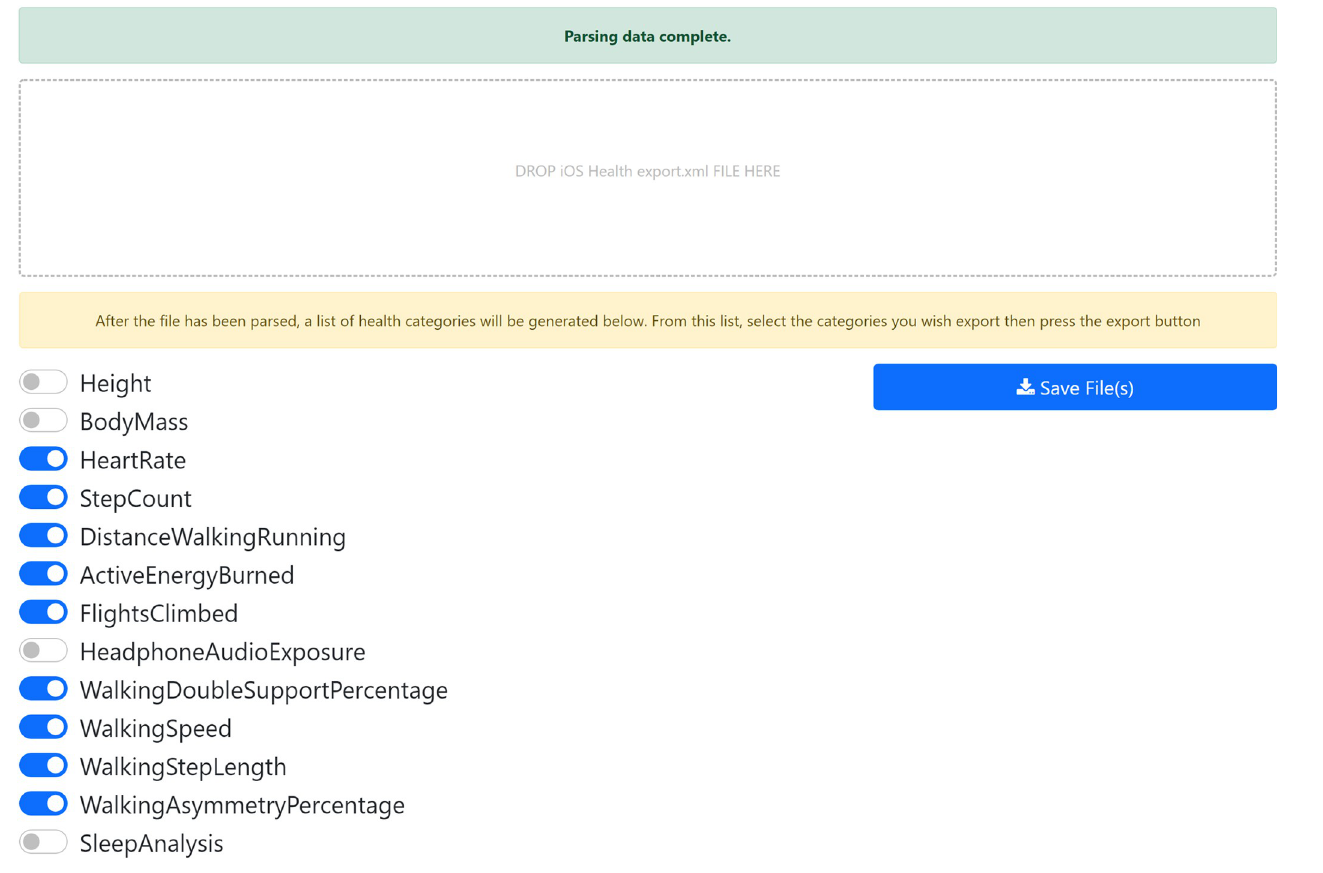
Fig 2. Screenshot of iOS Health Data Parser